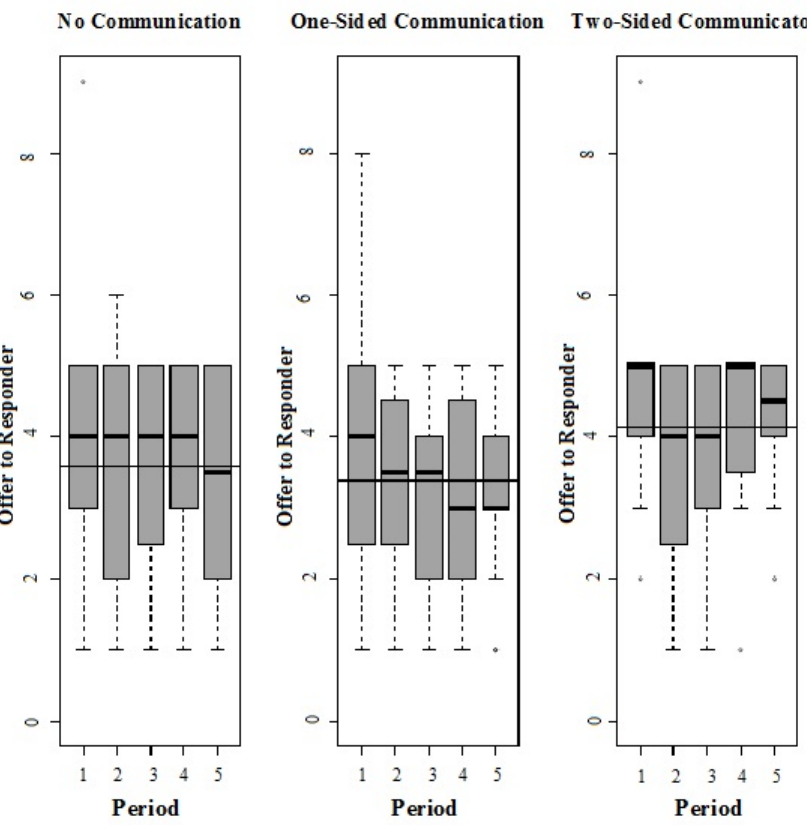
Figure 1. Choices of X (average at the individual